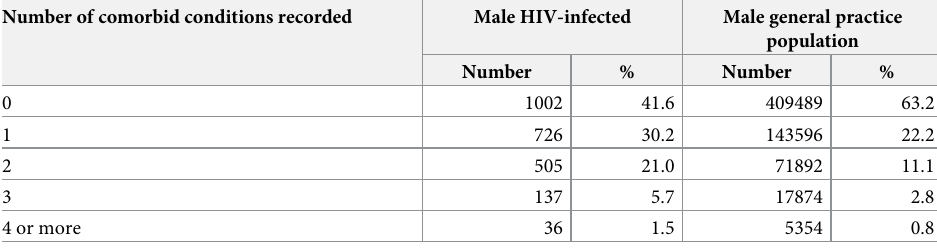
Table 3. Multiple NICMs recorded in male HIV-infected patients compared to the male general practice population. Number of comorbid conditions recorded Male